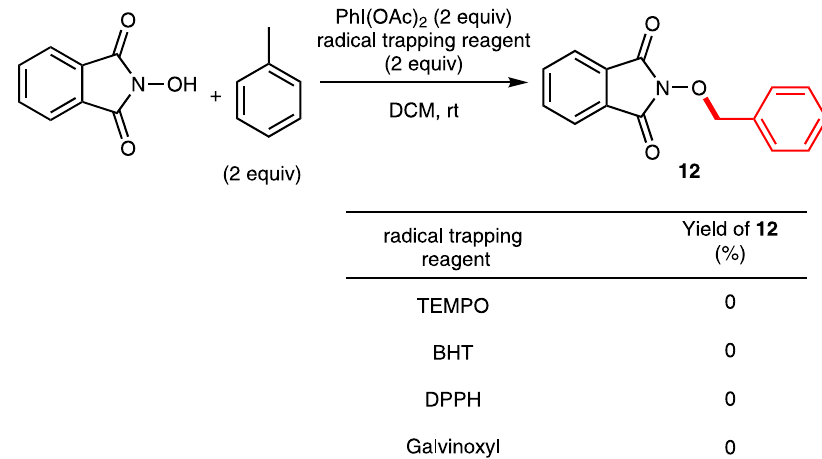
Fig. 5 Effect of radical trapping reagents to the reaction mixture. PhI(OAc) 2 (0.54 mmol), radical trapping reagent (0.54 mmol) and NHPI (0.27 mmol) were added to a solution of toluene (0.54 mmol) in DCM (2 mL).